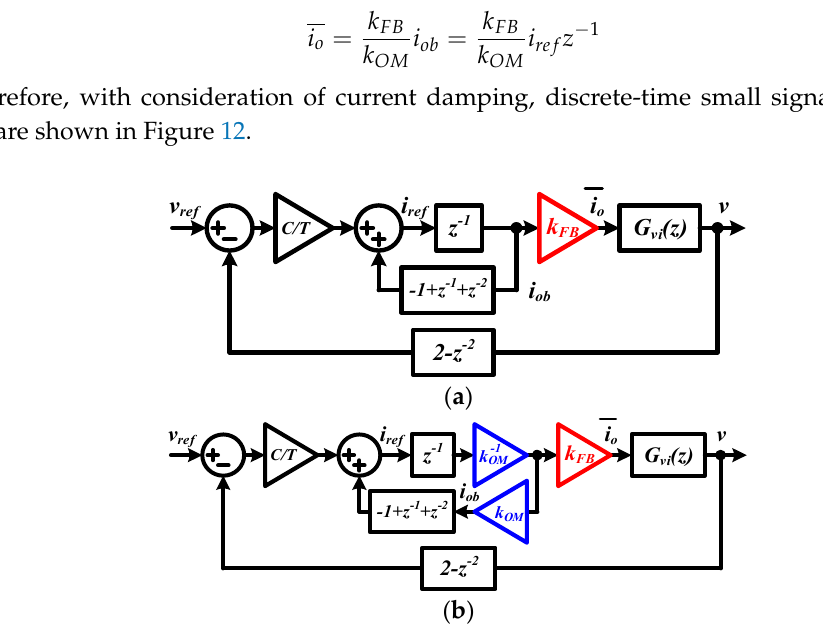
Table 1. Specifications of the Tested Flyback Converter. L m